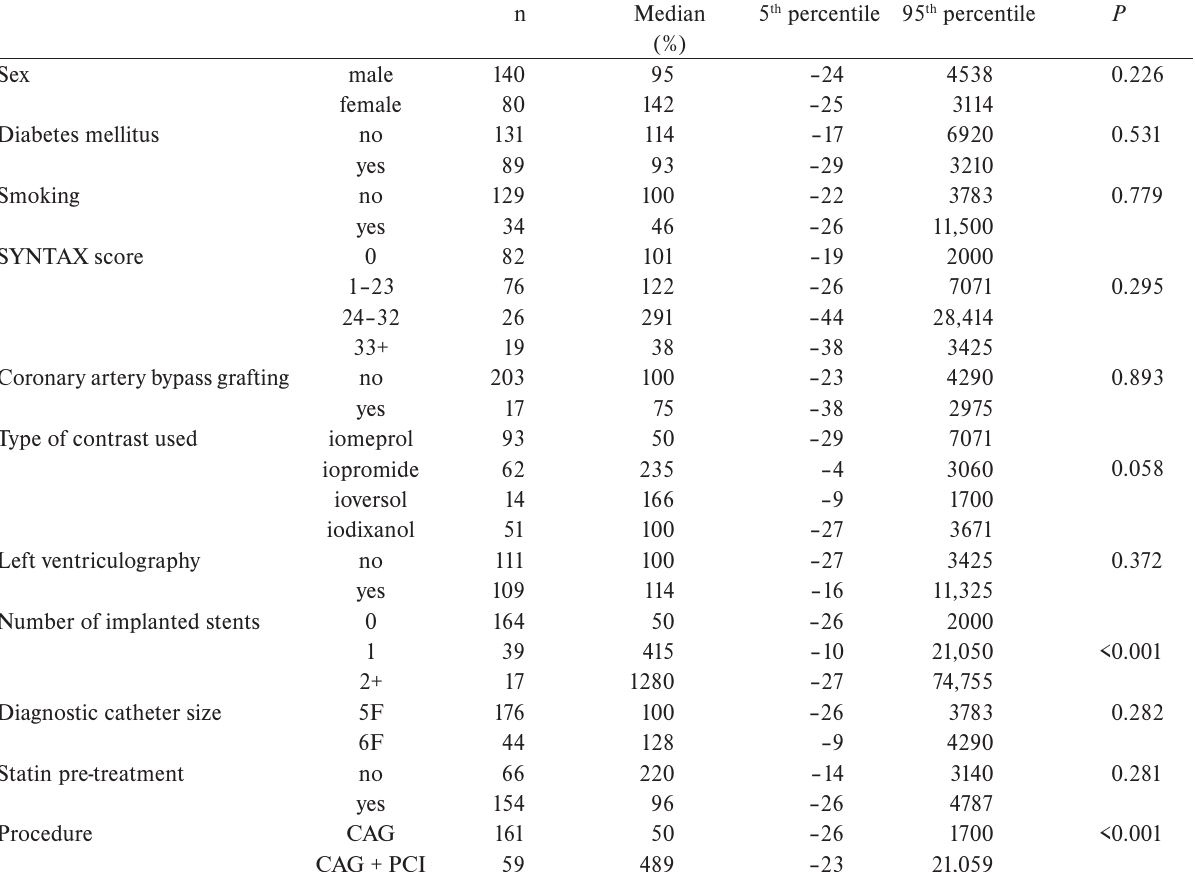
Table 4. Dependence of relative change in hs-cTnI on monitored variables (categorical data).